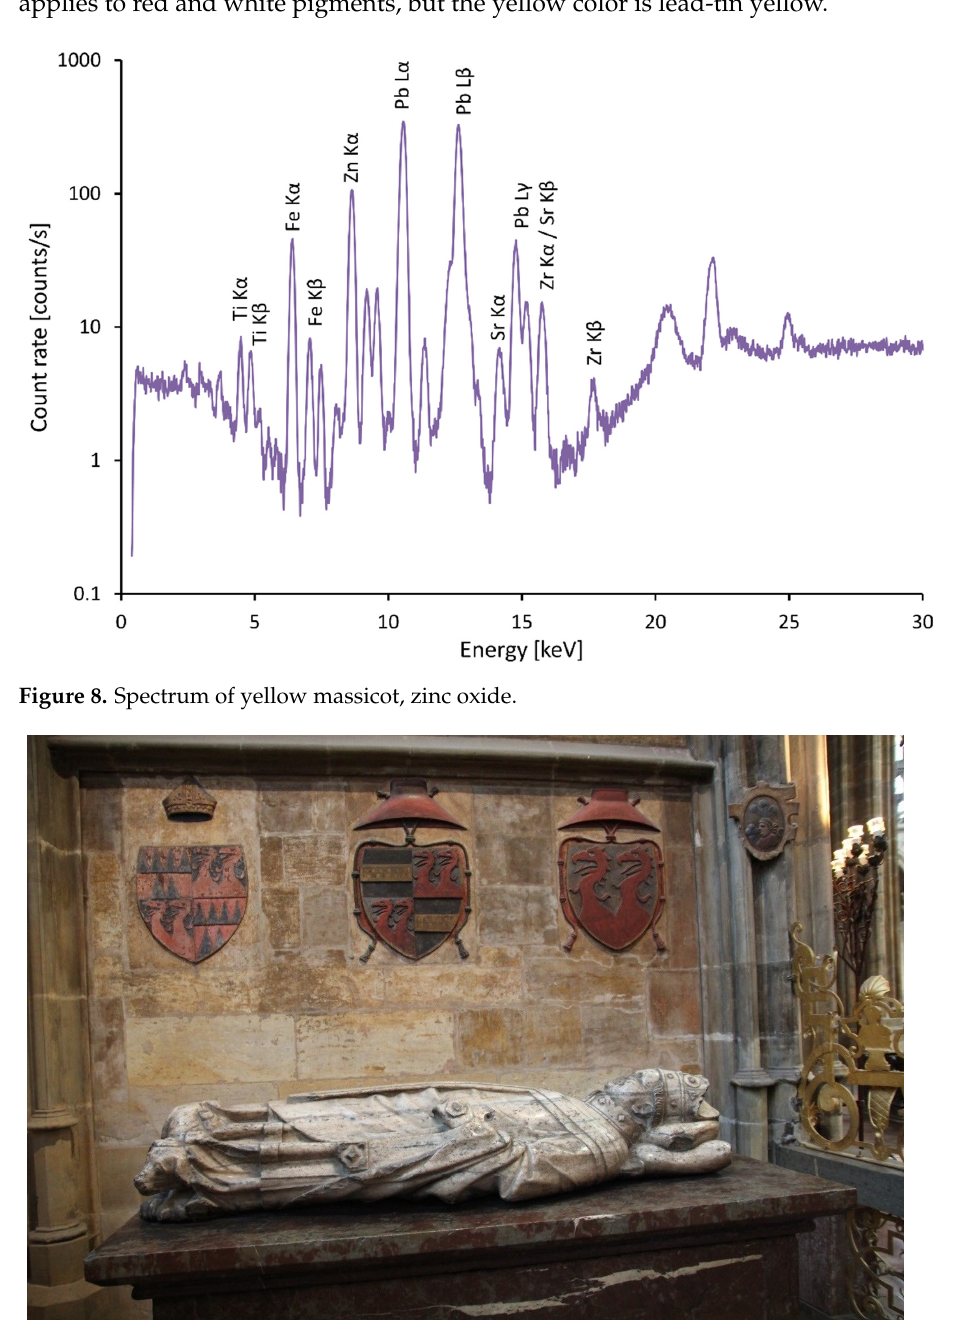
Figure 9. Coats of arms on Vlašim Chapel.